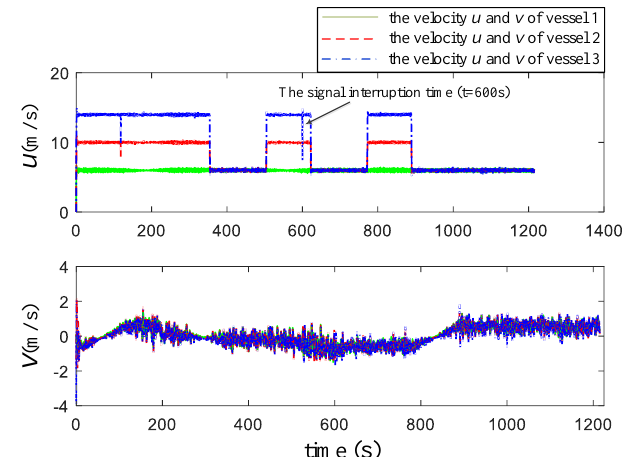
Figure 6. The position and orientation errors for the formation.